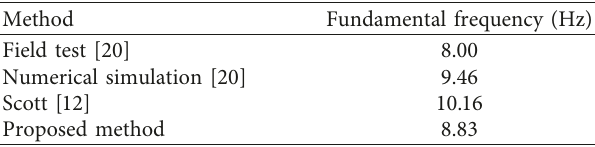
Table 3: Predicted results using different methods.